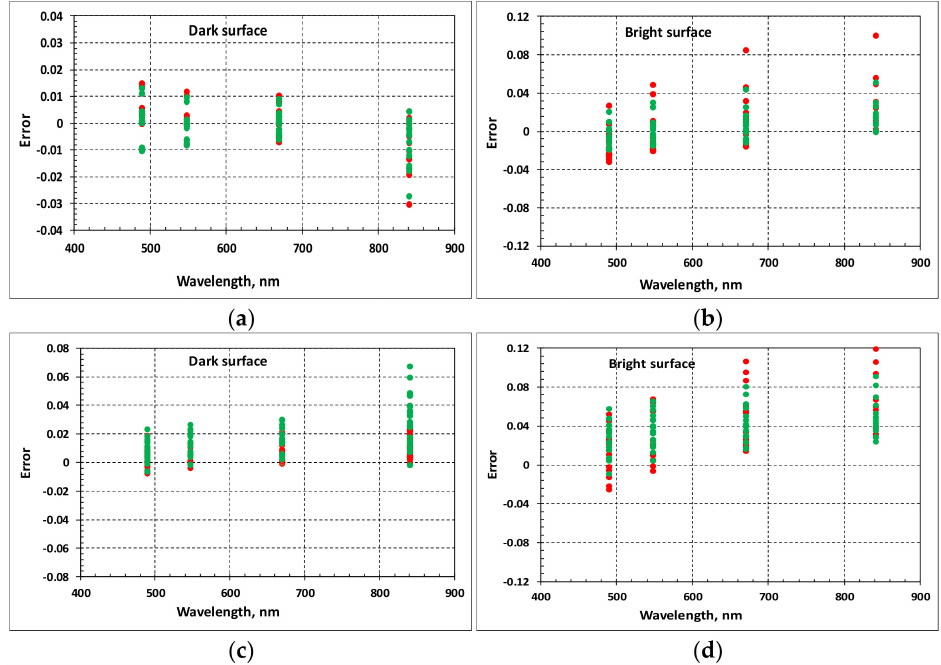
Figure 9. Errors in retrieving spectral reflectance of dark surfaces ( a , c ) and bright surfaces ( b , d ) in the MZ channels in the cases with “Belarus” ( a , b ) and ”Oceanic” ( c , d ) models as a true “real” atmospheric aerosol. Zenith angles of the solar are 60 ◦ (red circles) and 20 ◦ (green